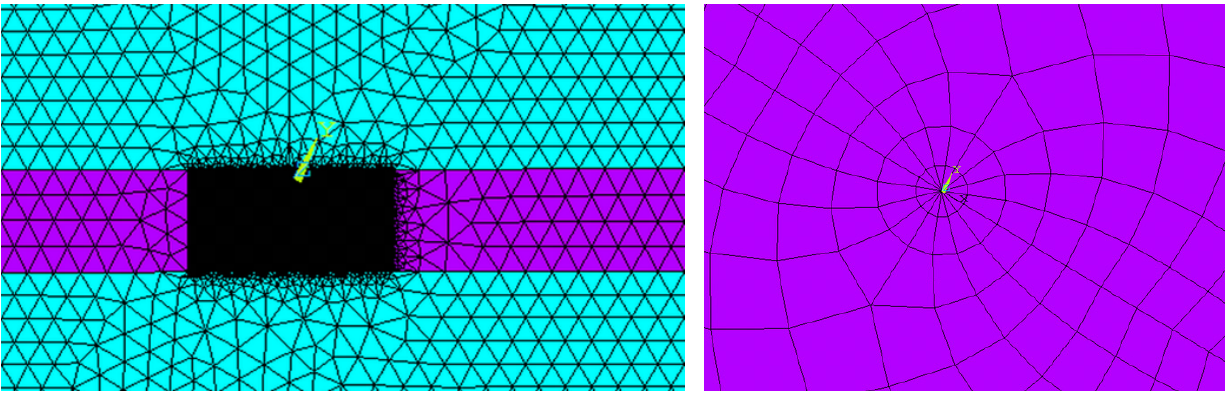
Figure 3: Detail of fine mesh around the crack